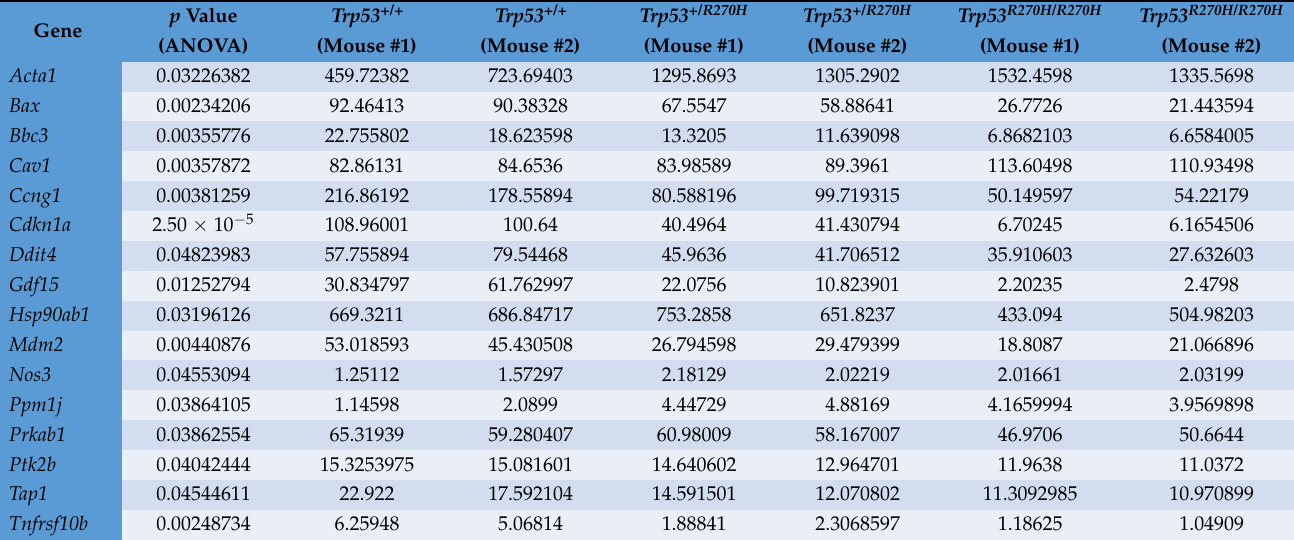
Table 1. Presence of the Trp53 R270H mutant allele mediates alterations in the expression levels of validated transcriptional targets of wildtype p53. The expression of 16 genes that are known transcriptional targets of wildtype p53 was impacted by the presence of the Trp53 R270H mutant allele. It is noteworthy that allele dosage effects were observed for some genes; Bax , Ccng1 , Cdkn1a , Gdf15 , Mdm2 . Data shown are fragments per kilobase of exon model per million mapped reads (FPKM).